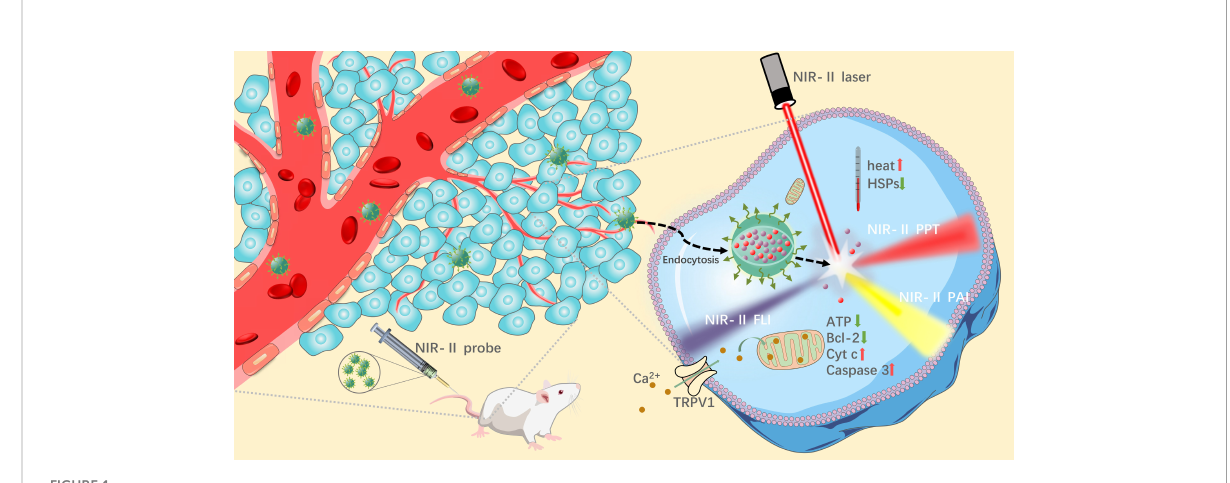
FIGURE 1 Schematic diagram of tumor imaging and PTT in the second near-infrared